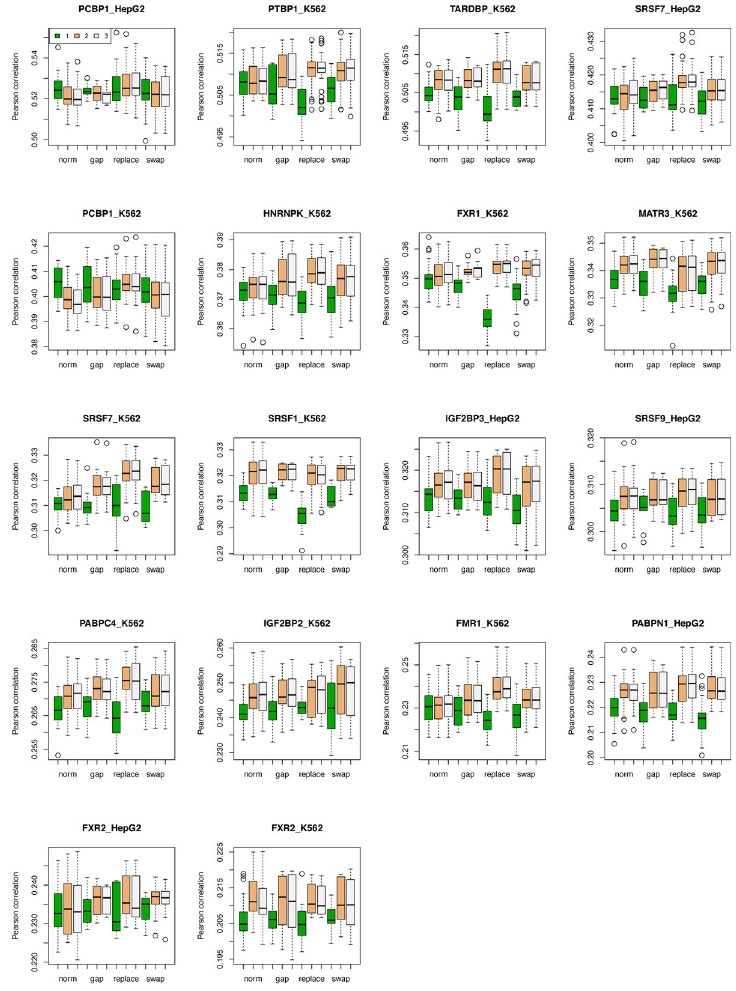
Fig 3. Performance of RBP-ADDA model after data augmentation operations. In each panel, the predictive performances on an RBP are grouped and shown as norm (non-augment), gap, replacement, and swap. Within each group, the performances after pre-training step, domain adaptation step and fine-tuning step are indicated as “1”, “2” and “3”.